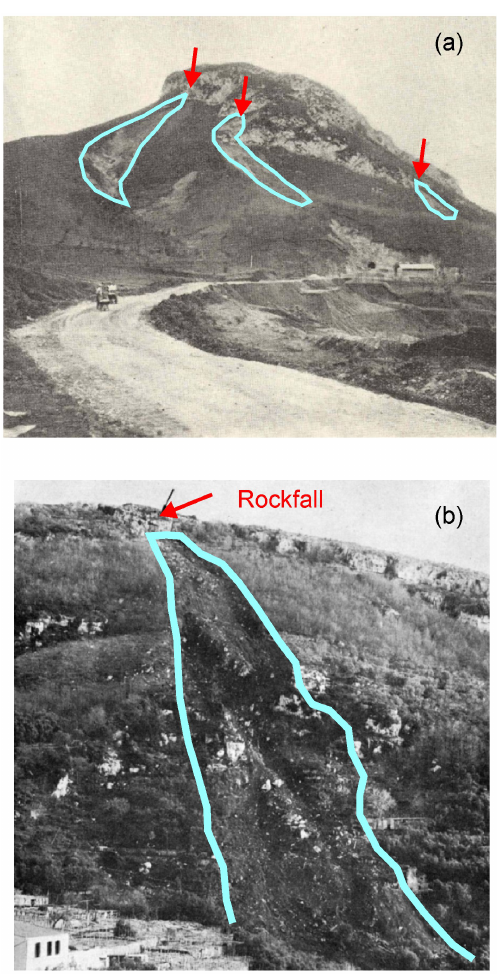
Fig. 2. Rockfall-induced debris flows affecting the Sorrento Peninsula-Lattari Mountains: (a) Mt. St. Liberatore in 1954; (b) Mt. St. Costanzo in 1973. The blue lines indicate the traces of rup- ture surfaces on original ground